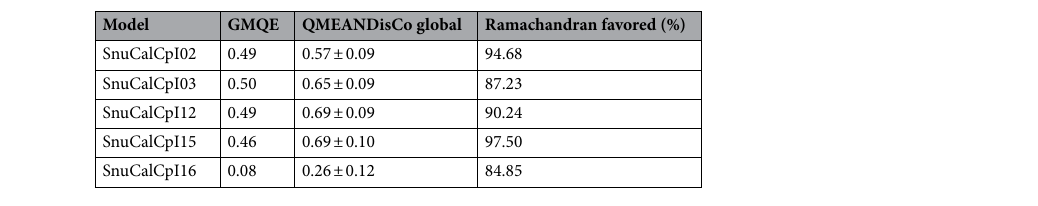
Table 1. Quality assessment scores of modeled